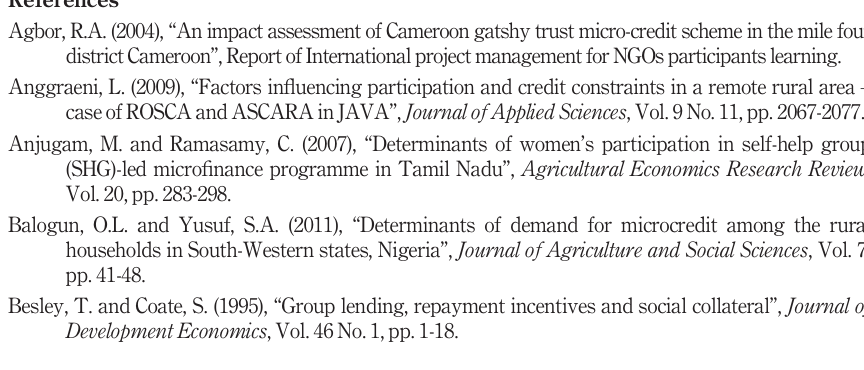
Table IV represents the comparison of SHG members ’ asset possession and annual household income, as well as the empowerment index before and after their joining the SHG. The value of the empowerment index was found to be 0.574 after joining the SHGs, in comparison with the index value of 0.334 before joining the SHG. There is a signi fi cant difference in both these values which suggests that the value of the empowerment index signi fi cantly increases after joining SHGs. The average asset(s) acquired by the members after joining SHGs was found to be 4,401, up from 2,534, the fi gure at the time when the respondent was a non-member. Again, with regard to assets possession, the statistics show that there is a signi fi cant difference in asset possession before and after joining the SHG. The average income of a household after joining SHGs was INR186,645, up from INR133,765. There is a signi fi cant increase in the average household income after joining